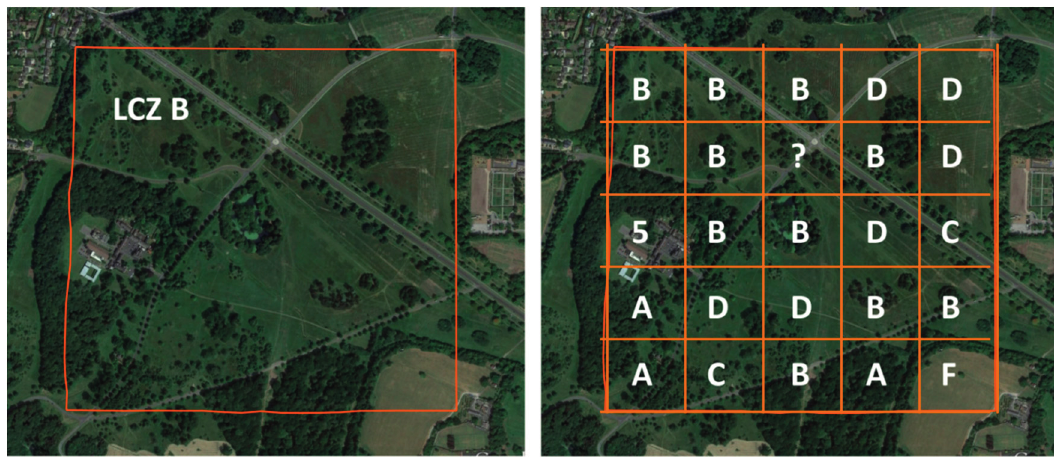
Figure 4. Scale dependency of the LCZ concept. Possible classification results in 1000 m resolution ( left ) and 200 m ( right ) for Phoenix Park, Dublin. Imagery: Google